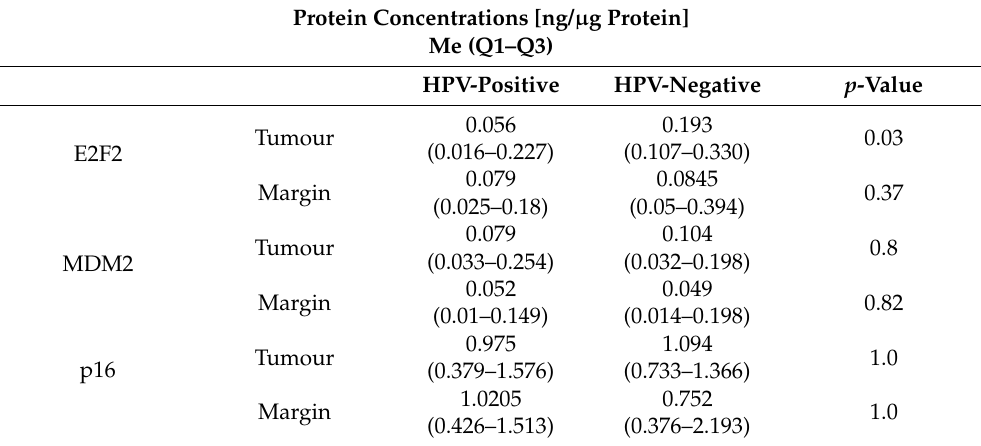
Table 4. E2F2, MDM2 and p16 protein concentration analyses in smokers vs. non-smokers; drinkers vs. non-drinkers; smokers and drinkers vs. non-smokers and non-drinkers. Protein Concentrations [ng/ µ g